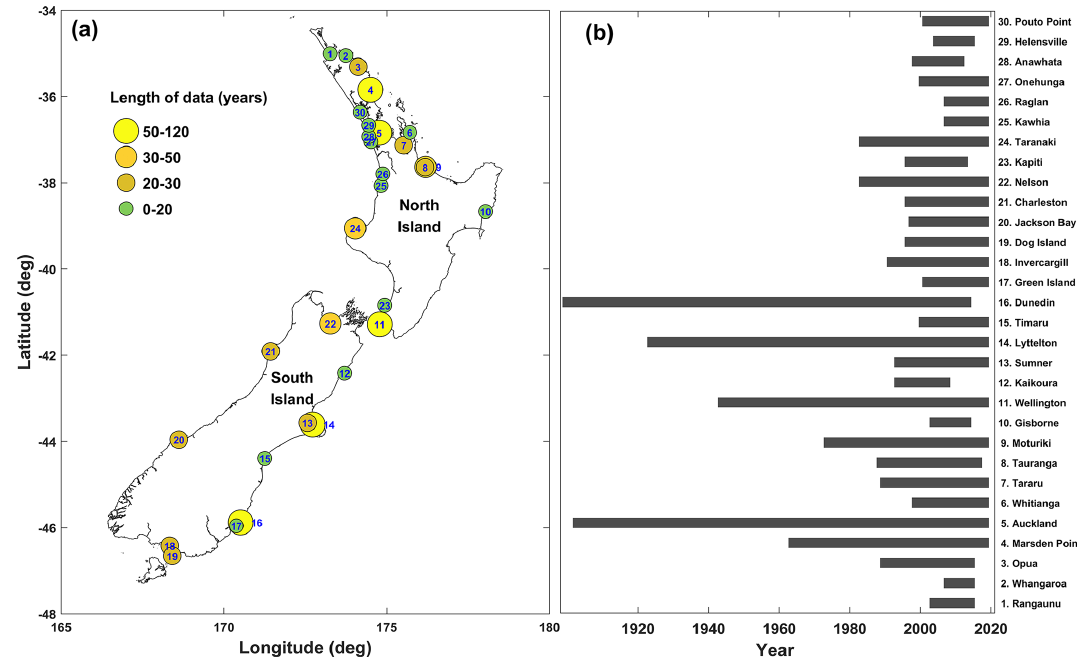
Figure 1. (a) Location of tide gauge sites around NZ, with site number and (b) duration of the sea-level